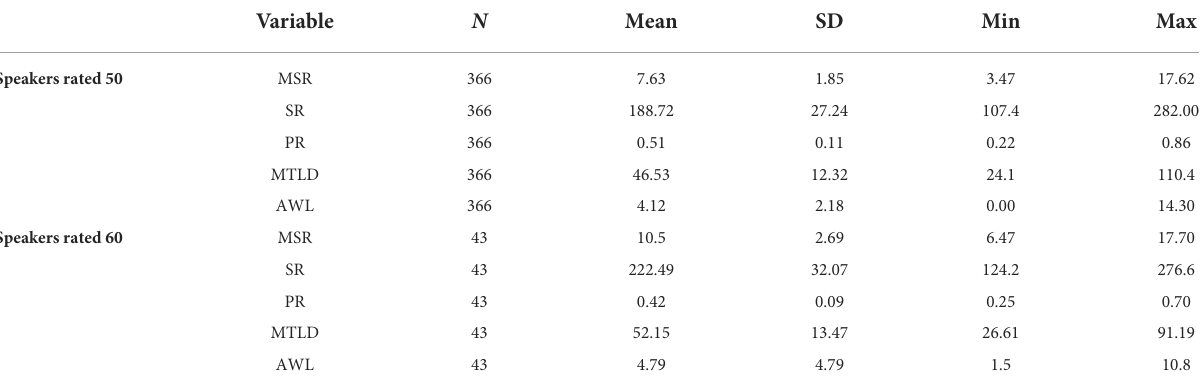
TABLE 3 Descriptive statistics of fluency and vocabulary measures.